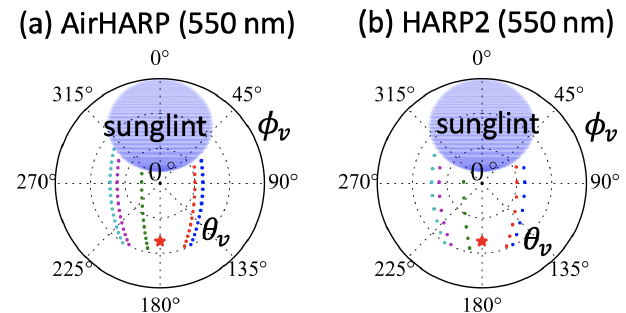
Figure 4. Example viewing zenith ( θ v ) and relative azimuth ( φ v ) in a polar plot at 550nm for AirHARP (20 angles) and HARP2 (10 angles). Five sets of examples are provided in different colored dots. The 440 and 870nm bands are similar. At 670nm, there is a total of 60 angles for both instruments. The anti-solar point is indicated by the red asterisk. The viewing angles within the sunglint region indicated by the blue shaded area are removed. Note that the viewing angles from HARP2 are downsampled from